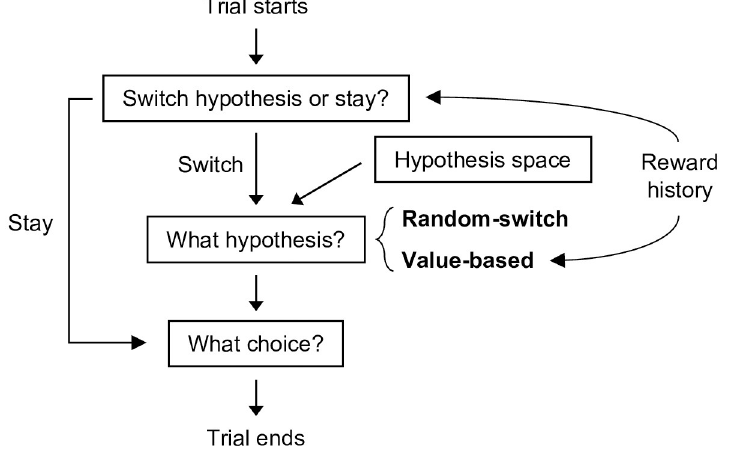
Fig 3. A diagram of the serial hypothesis testing